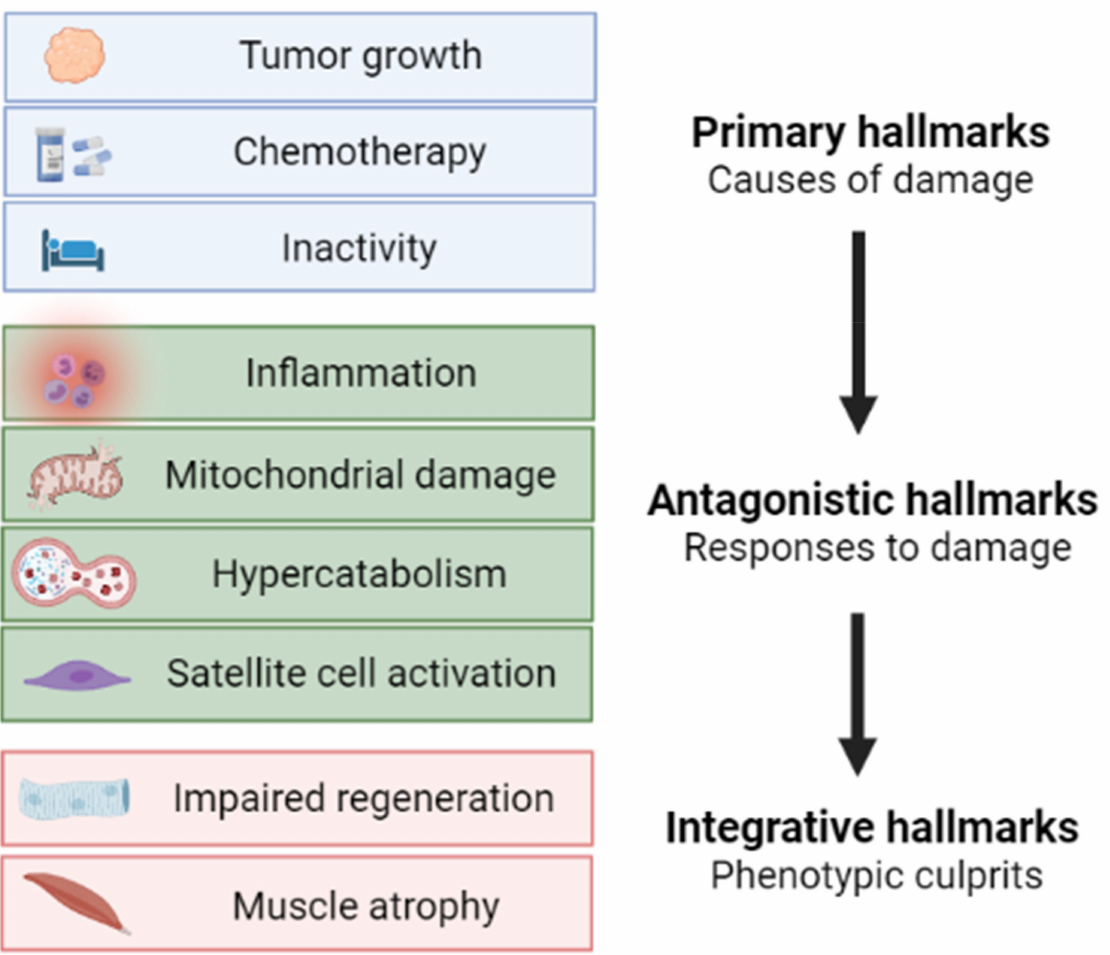
Figure 4. Proposed schematic pathogenesis of muscle wasting in cancer cachexia according to primary, antagonistic, and integrative hallmarks. Image created with BioRender.com (accessed on 17 August